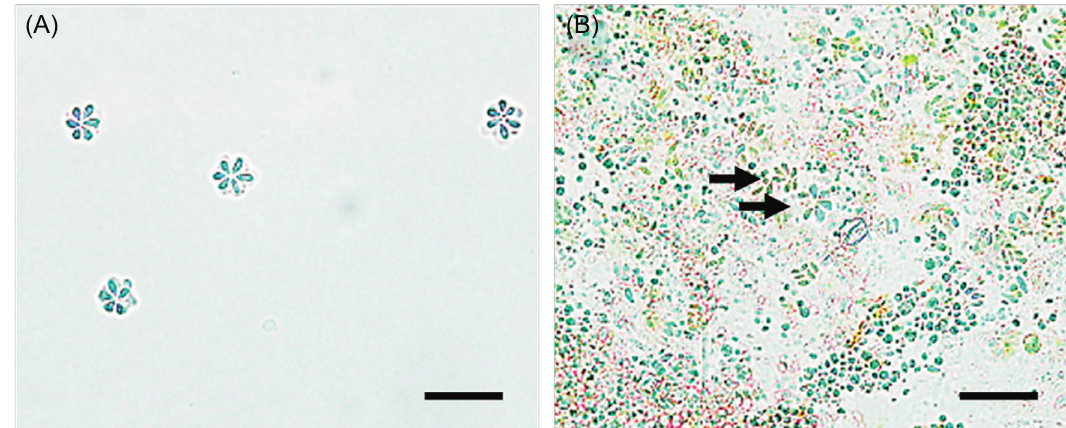
Figure 4. Unstained faecal wet smear from suckling mice orally administered Kudoa septempunctata spores. (A) Phase contrast micrograph of K. septempunctata spores in inoculation solution. (B) Kudoa spores detected in faeces 12 h post-ingestion. Scale bar = 20 l